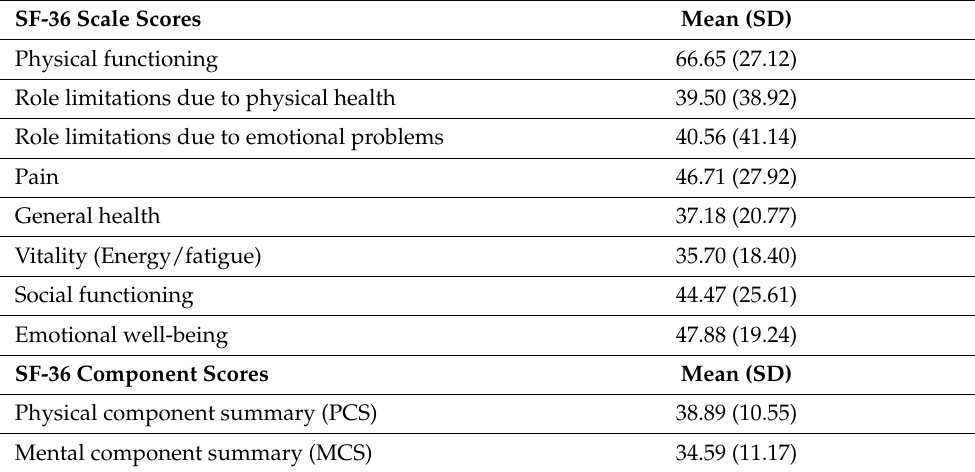
Table 2. SF36 Scale scores and summary components (All participants n =